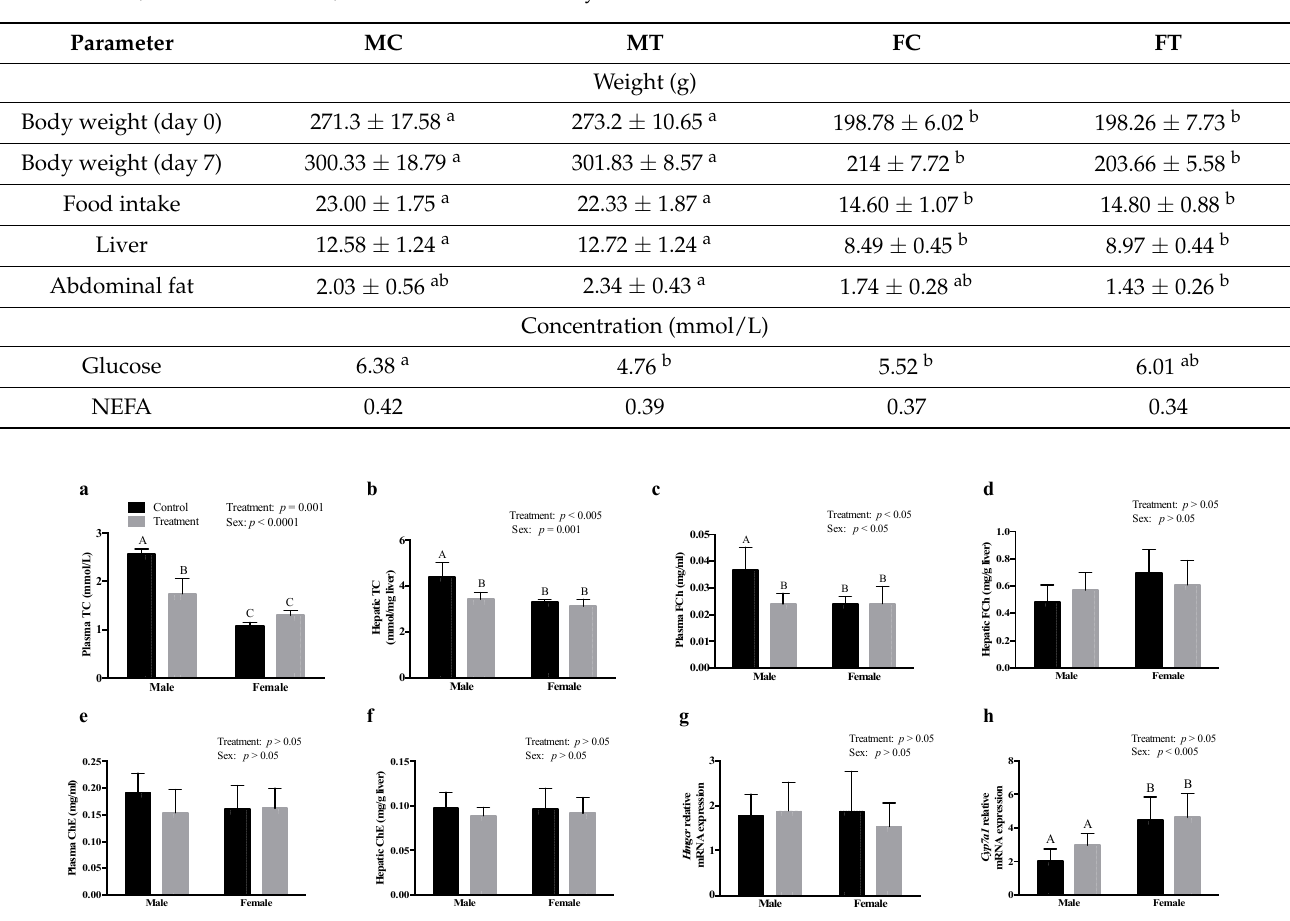
Figure 1. Intraperitoneal administration of SCFAs had sex-specific effects on cholesterol metabolism. Effect of SCFAs on, ( a ) plasma total cholesterol (TC), ( b ) plasma FCh, ( c ) plasma cholesteryl esters (ChE), ( d ) hepatic TC, ( e ) hepatic FCh, ( f ) hepatic ChE, and the relative mRNA abundance of ( g ) Hmgcr and ( h ) Cyp7a1 . The mRNA expression data are presented relative to β -actin. Data were analyzed using two-way ANOVA followed by Tukey’s post hoc test. All data are expressed as mean ± SD. Different superscripts indicate significant differences amongst groups; p < 0.05 was considered significant ( n = 6). Cyp7a1— cholesterol 7 α -hydroxylase, FCh—free cholesterol, Hmgcr— 3-hydroxy-3-methylglutaryl-CoA reductase, SCFAs—short-chain fatty acids.